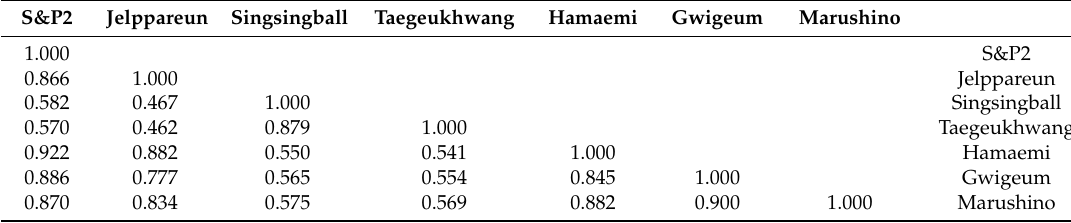
Table 5. Pairwise population matrix of Nei’s genetic